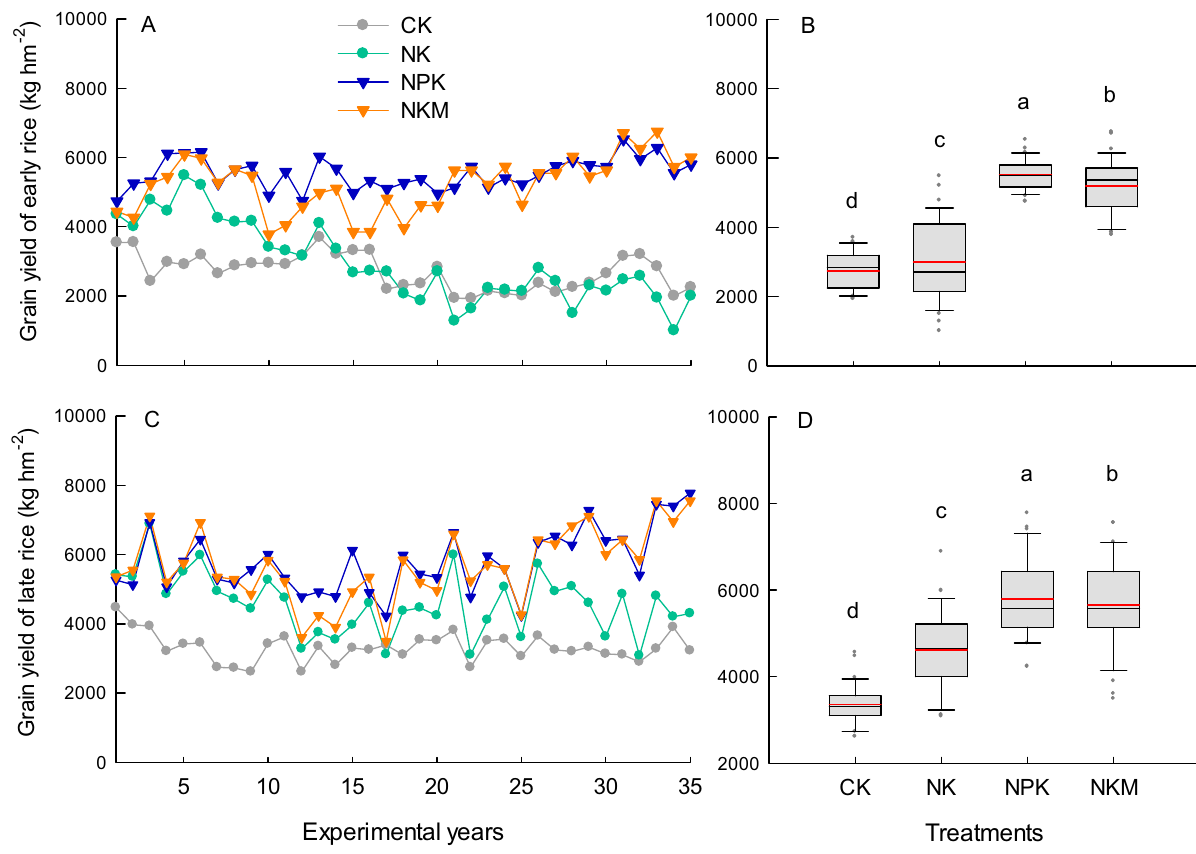
Figure 1. Variation and distribution of grain yields for early rice ( A , B ) and late rice ( C , D ) under different fertilization treatments CK, NK, NPK and NKM across 35 years. Red lines indicate the mean value, and different lower case letters indicate significant differences for the mean grain yield (n = 3) between treatments at p < 0.05 in ( B , D